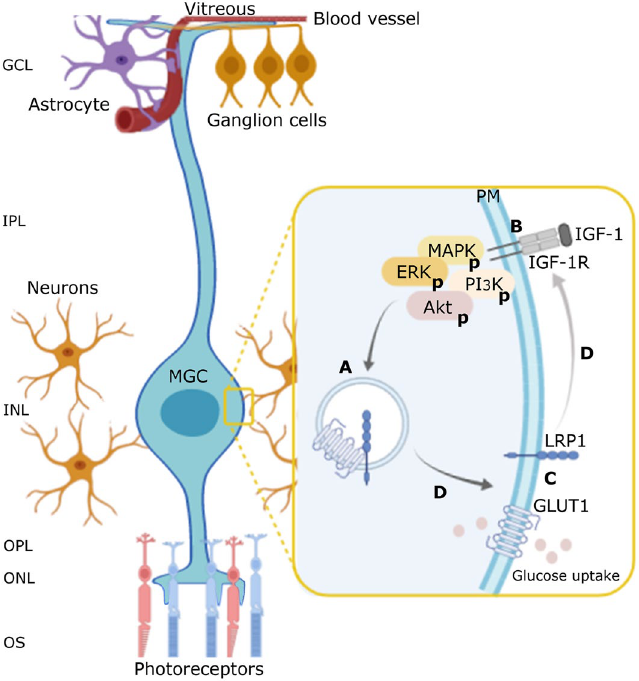
Figure 6. Schematic model of LRP1 mediation in GLUT1 translocation to cell surface and glucose uptake induced by IGF-1. ( A ) Representative image in which, in non-stimulated MIO-M1 cells, LRP1 and GLUT1 are stored in same, but uncharacterized vesicles, since they are molecularly associated through a possible direct interaction or mediated by adaptor proteins. This molecular association would be necessary to retain GLUT1 inside the cells. ( B ) IGF-1 induces MAPK/ERK and PI3K/Akt signaling activation through its cognate receptor (IGF-1R). ( C ) This IGF-1-induced activation promptly leads to the molecular dissociation of LRP1 and GLUT1, promoting the intracellular traffic of both membrane proteins to the PM and glucose uptake. Nevertheless, if both intracellular signaling pathways have different downstream targets on the GLUT1 traffic are still unknown. ( D ) The LRP1 knockdown fully abrogates the IGF-1R intracellular signaling, the GLUT1 translocation and glucose uptake processes. Taken account these considerations, we propose that the LRP1 mediation in the IGF-1-induced glucose control in MIO-M1 cells may be focused at two levels: (1) by regulating the intracellular traffic of GLUT1, and (2) by acting as a scaffold protein for the IGF-1R activation. Ganglion cell layer (GCL), inner plexiform layer (IPL), inner nuclear layer (INL), outer plexiform layer (OPL), outer nuclear layer (ONL), outer segment layer